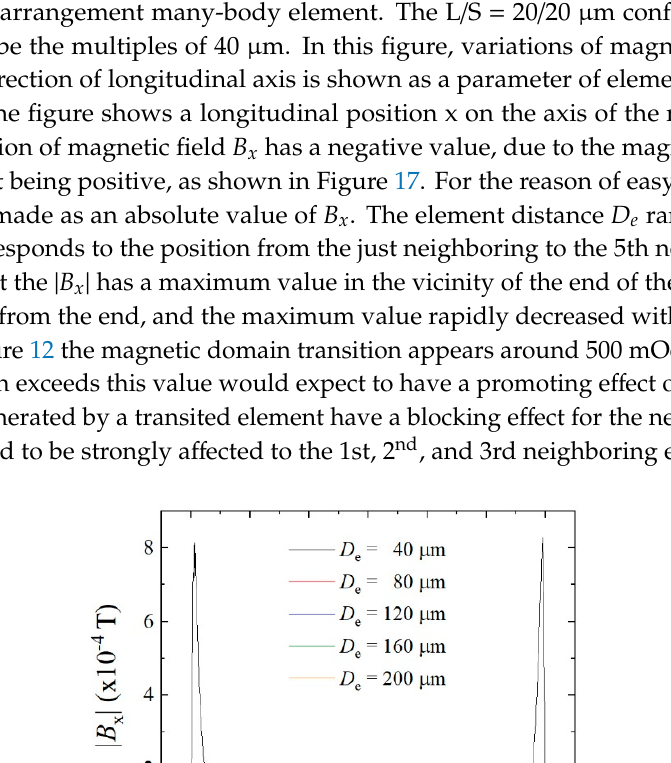
Figure 18. Magnetic field distributions along the axis of elements in the neighboring element position.